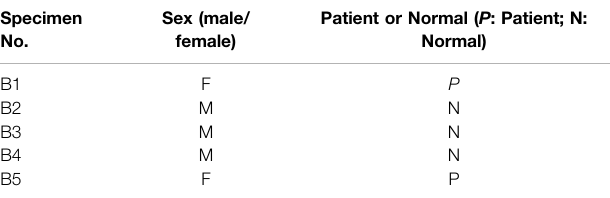
TABLE 1 | Sample information. Specimen